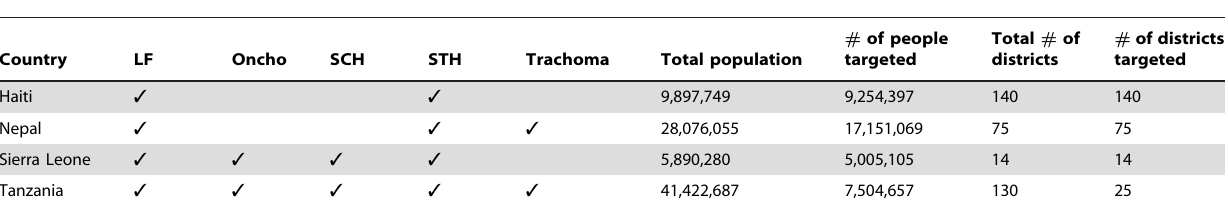
* The demographic and district figures from Table 1 represent country situations at the time of data entry. doi:10.1371/journal.pntd.0002619.t001 PLOS Neglected Tropical Diseases |